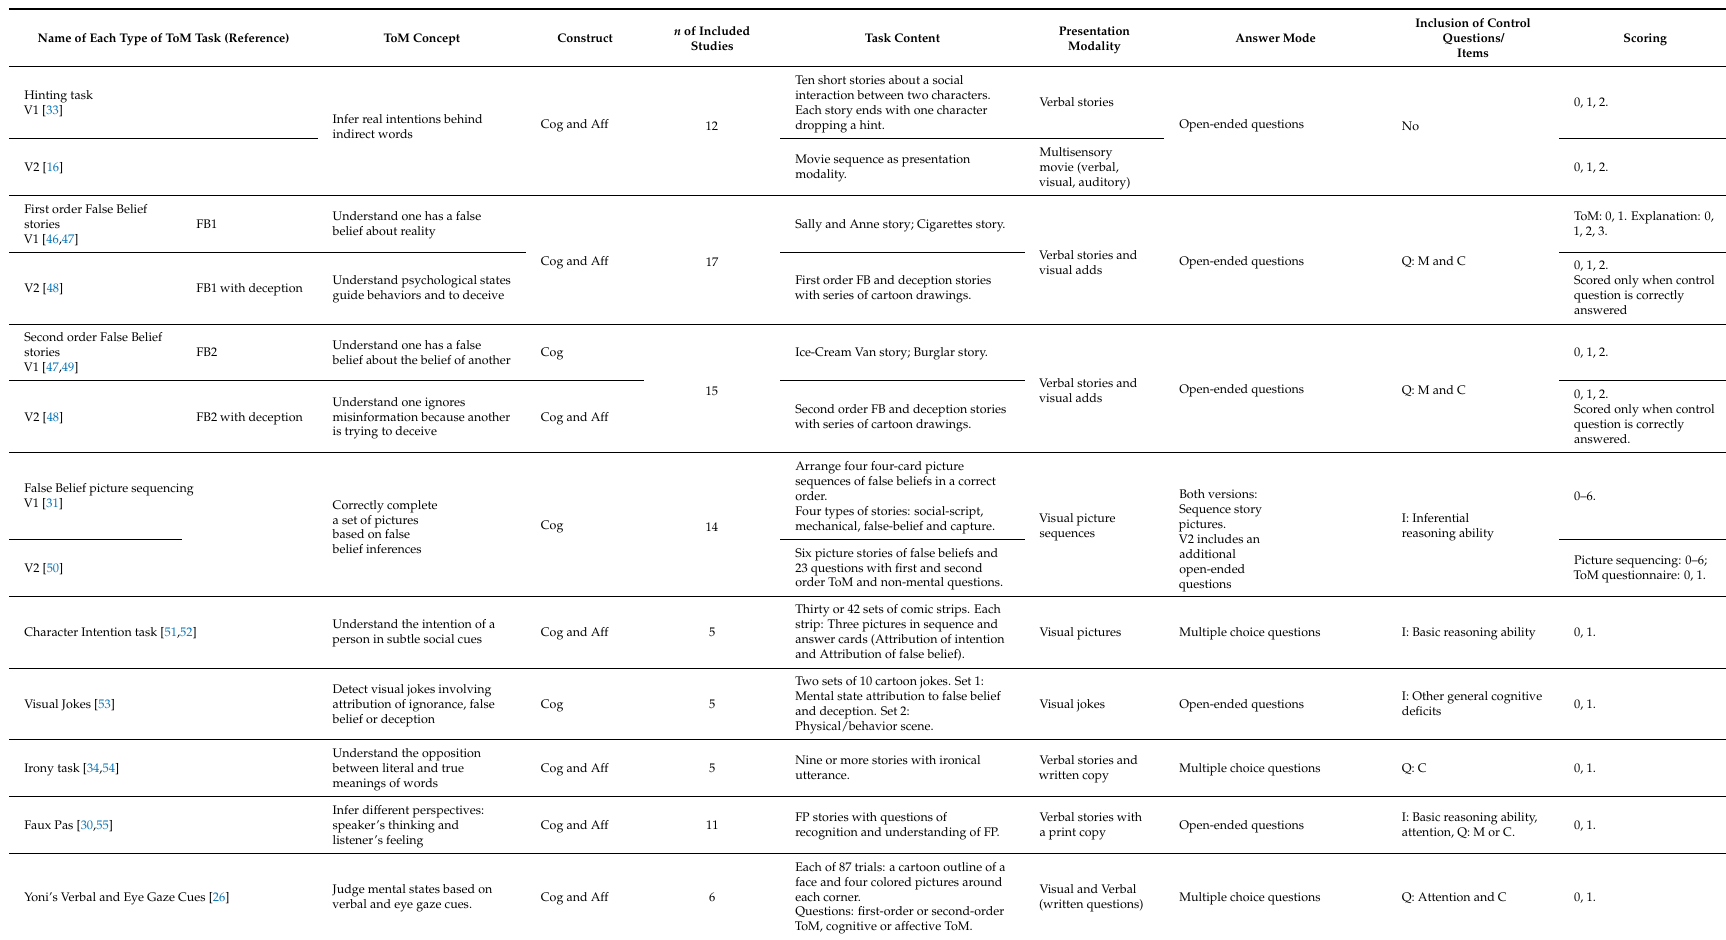
Table 2. Types, concept, construct and administration of the current ToM